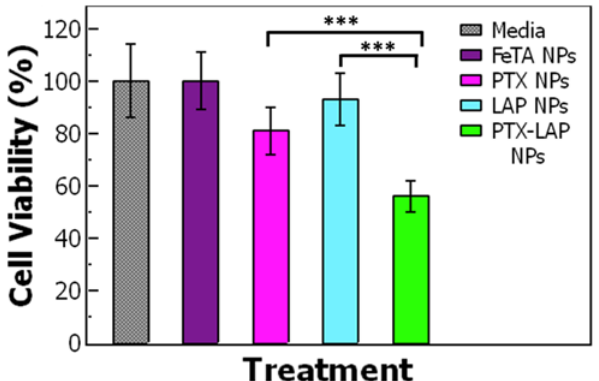
Figure 5. Cell viability of OVCA-432 cells after the 48-hour treatment with (gray) media, (purple) tannic acid–iron nanoparticles (TA–Fe NPs), (pink) paclitaxel nanoparticles (PTX NPs), (light blue) lapatinib nanoparticles (LAP NPs), (green) paclitaxel–lapatinib nanoparticles (PTX–LAP NPs). The cells were treated with a PTX concentration of 0.009 µg/mL and LAP at 0.004 µg/mL based on IC-50 of the PTX–LAP NPs. The cell viability was significantly lower when the cells were treated with PTX– LAP NPs when compared to PTX NPs ( p < 0.05) and LAP NPs ( p < 0.05). The graph shows the average ± standard deviation from one experiment performed with 6 replicate wells.